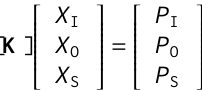
input and a single output.